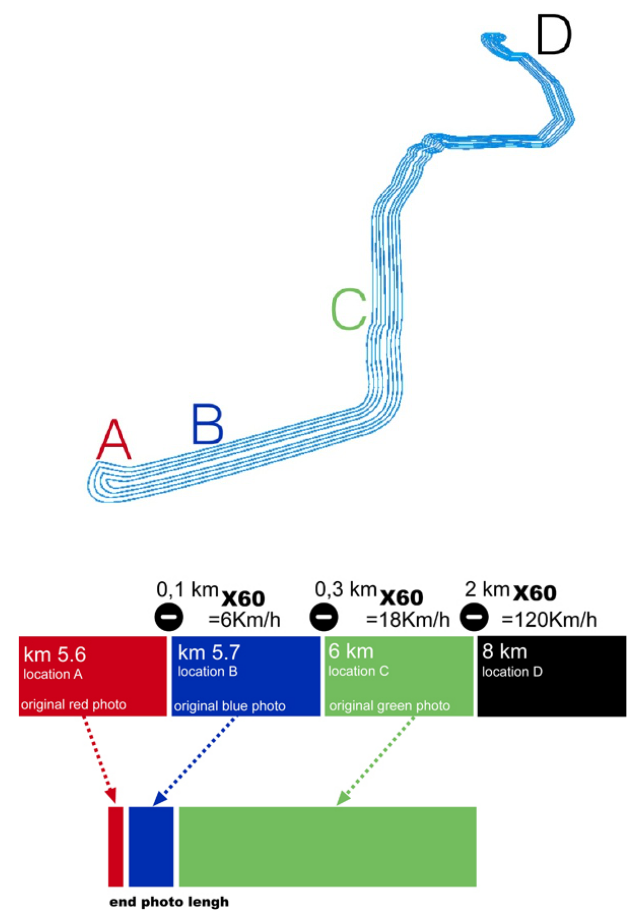
Fig. 6. Image length